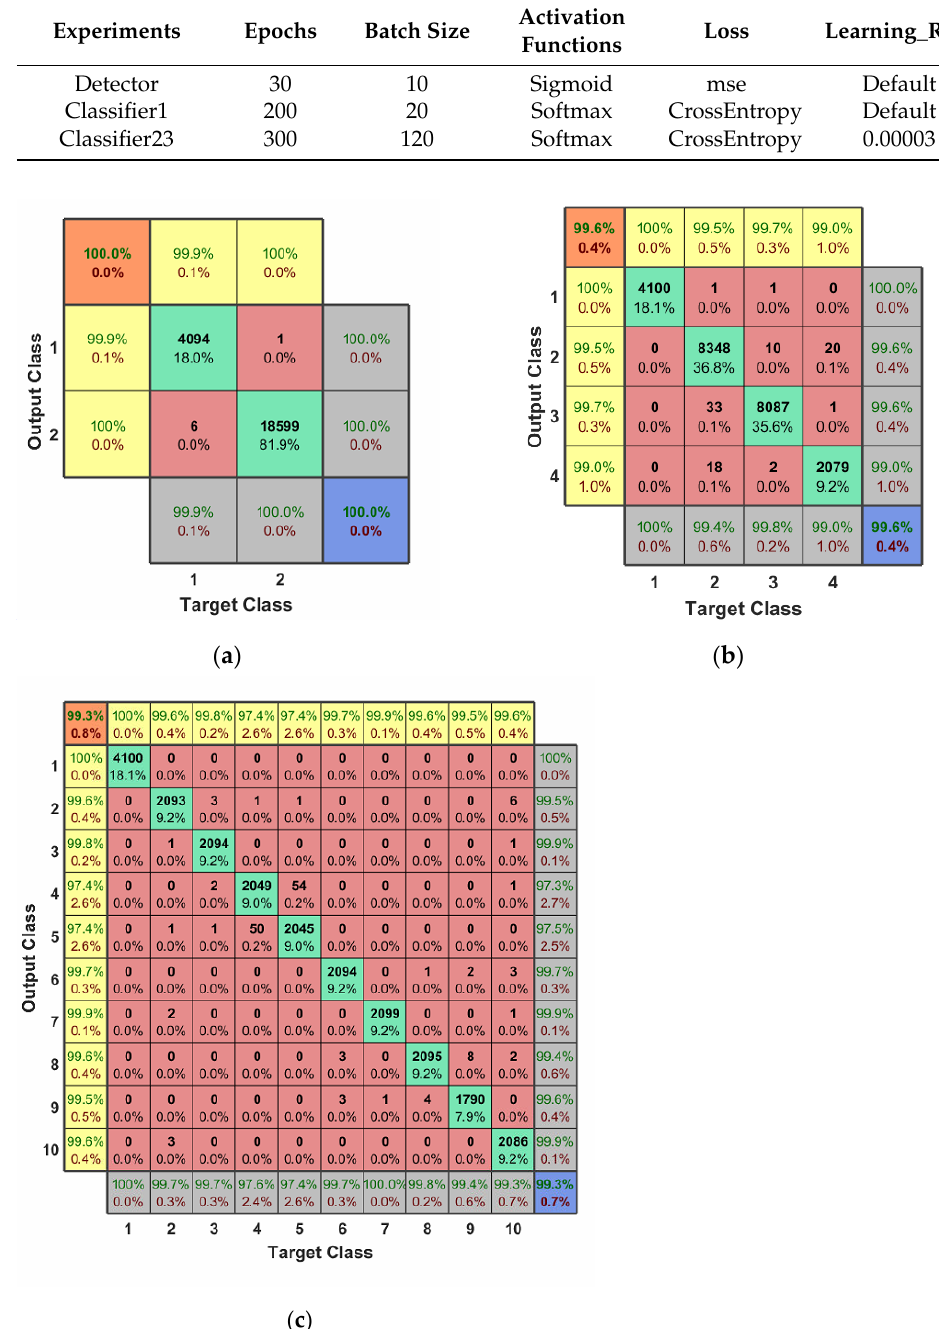
Figure 4. The output confusion matrix for 2-classes, 4-classes, and 10-classes scenario: Where ( a ) is the 2-classes output confusion matrix (detecting the presence of a drone); ( b ) is the 4-classes output confusion matrix (detecting the presence of a drone and identification its type); and ( c ) is confusion matrix of outputs for 10-classes scenario (detecting the presence of a drone, identification its type, and determining its flight mode.). Worth noting: the rows and columns of this matrix's interior correspond to the predicted and true classes, respectively. The diagonal cells highlighted in green indicate correctly classified segments, while the non-diagonal cells indicate incorrectly classified segments, with the total number of segments and percentage of segments in each cell in bold. Next, the grey column on the far right shows Precision in green and FDR in red; the grey row at the bottom shows Recall in green and FNR in red; the blue cell in the bottom right corner of the figure shows Overall Precision in green and Error in red; the yellow column and row on the far left and top show the F1 score predicted for each class in green and it shows complementarity (completeness) in red; the orange cell in green indicates the average F1 score for all classes, and in red its complementarity. 5. Comparison with Other Methods We compare the method proposed in this paper with other papers using the same dataset [27–30]. In paper [29], the authors used four fully connected layers to build a DNN network and utilized 10-fold cross-validation for training to verify the validity of the dataset; in paper [30], the authors tried to use CNN instead of DNN to solve the detection problem and obtain better accuracy; and in paper [27], the authors used only the lower band of RF signals and XGBoost algorithm to solve the classification problem. In the paper [28], the authors combine KNN and XGBoost to solve the pattern classification problem of UAVs using an integrated learning approach. Table 5 summarizes the performance of the five methods, and the results demonstrate that: firstly, the effectiveness of using compressed sensing techniques on sampling the communication signals between the UAV and the controller is verified; and secondly, it shows that the method used in this paper outperforms other learning methods in terms of accuracy, F1 score, and recall, at very low sampling rates.